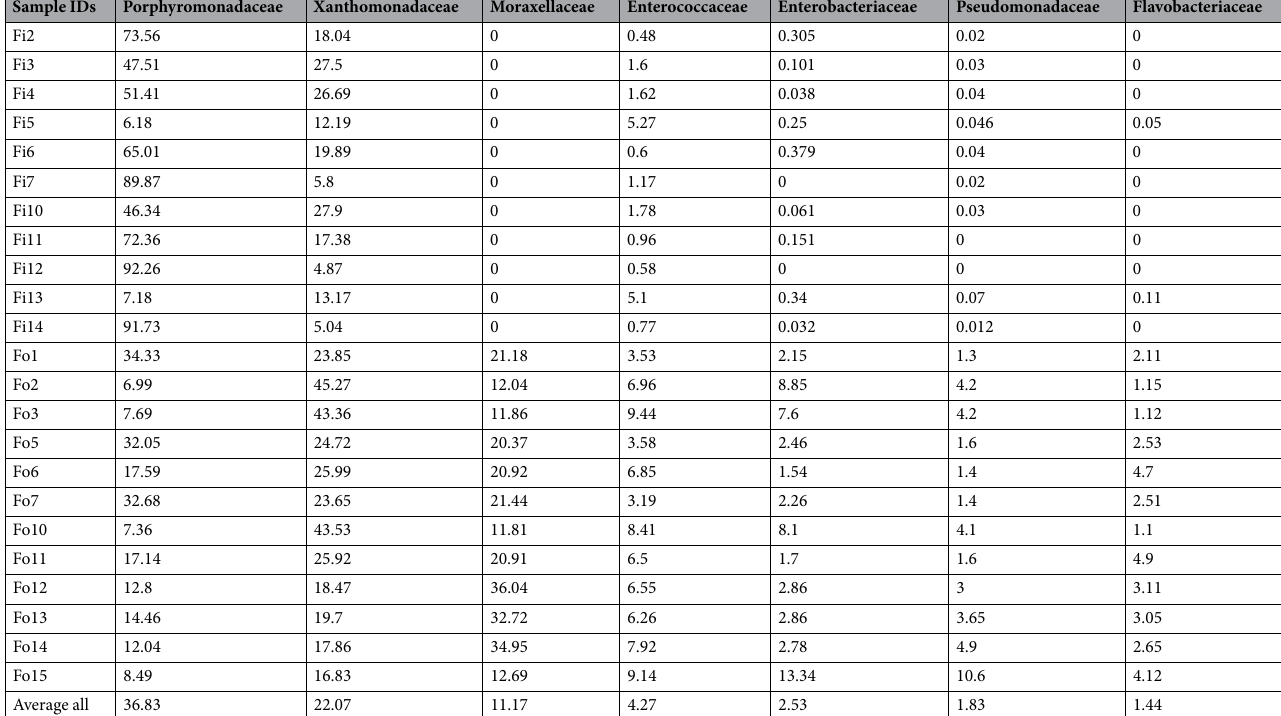
Table 1. Overall relative abundances (%) across samples at the family level. Sample IDs: Fi2 to Fi14,